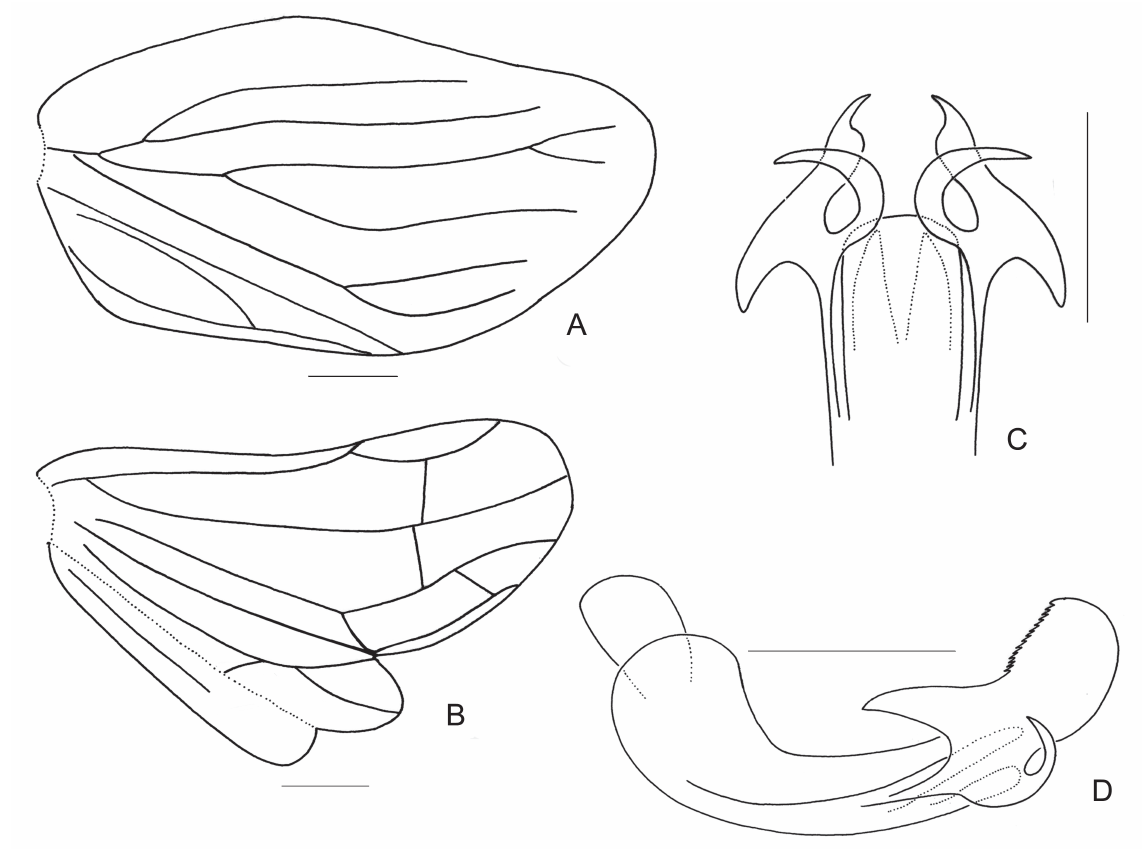
Fig. 7. Neokodaiana minensis Meng & Qin, sp. nov., holotype. A . Tegmen. B . Hind wing. C . Penis, apical half, ventral view. D . Penis, left view. Scale bars = 0.5